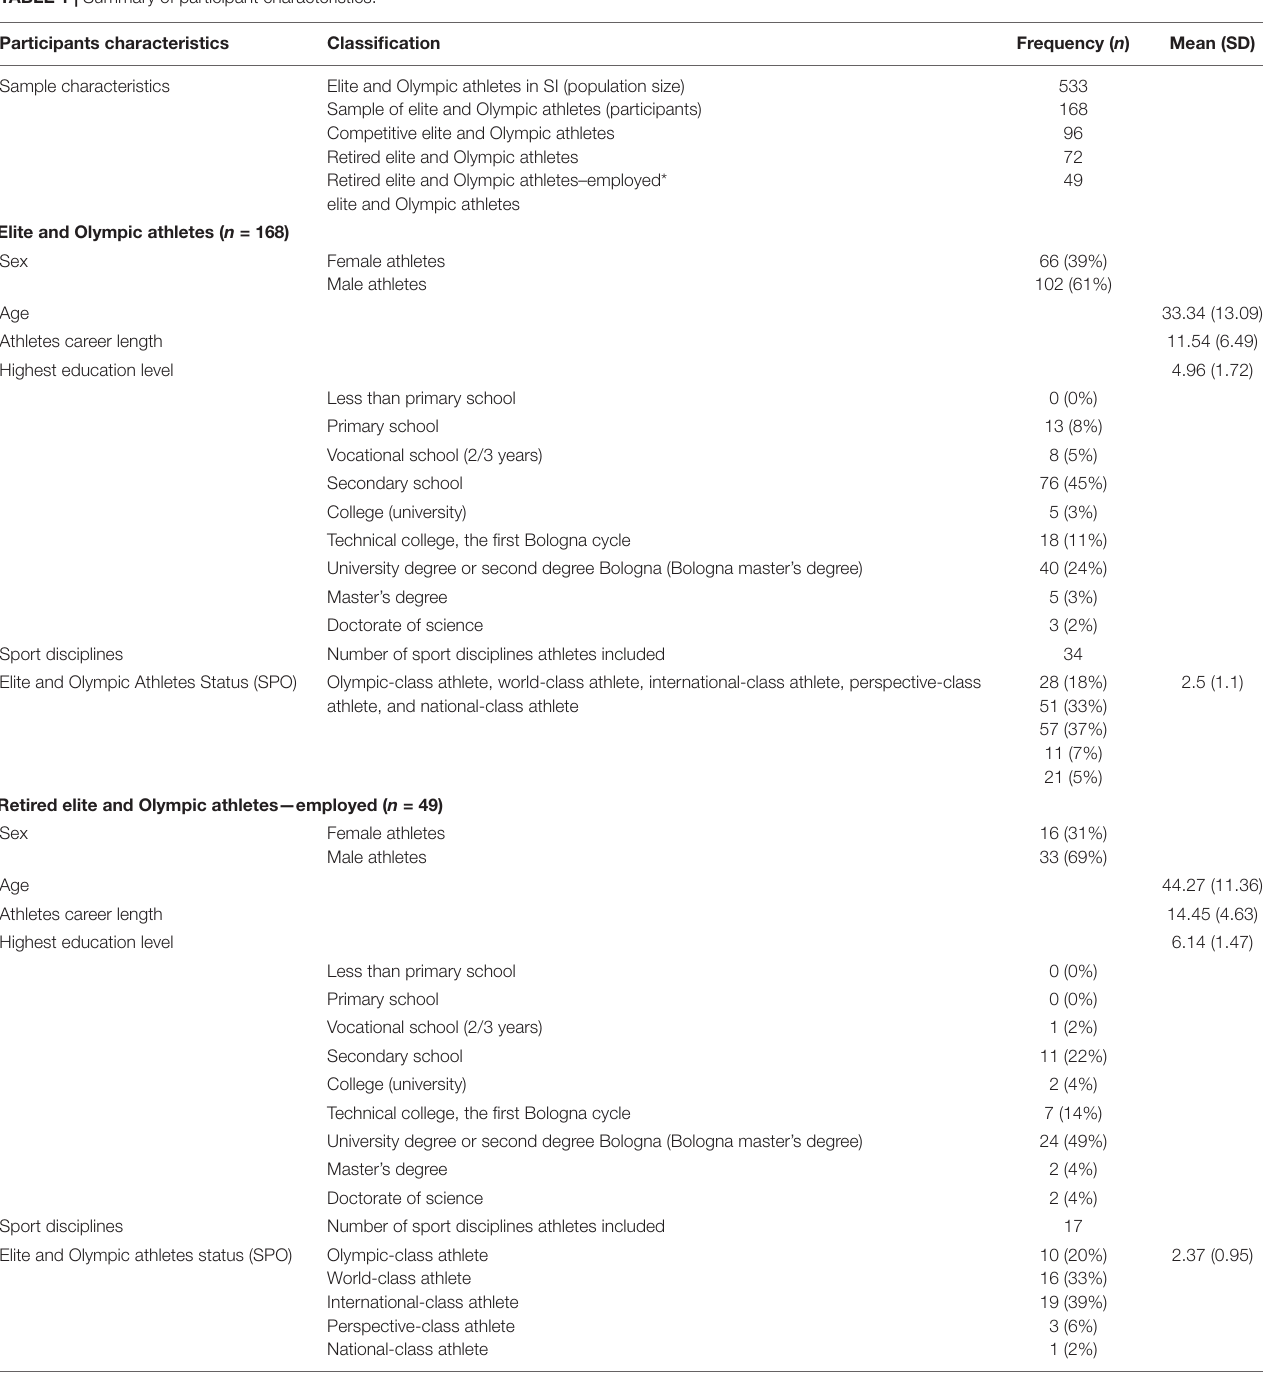
TABLE 1 | Summary of participant